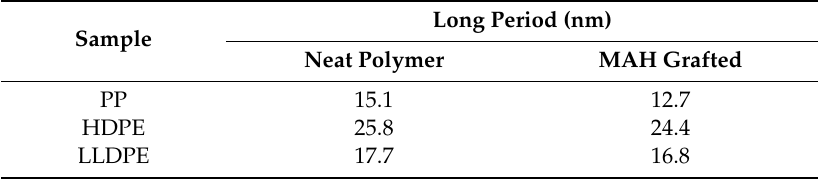
Table 3. Long period obtained from Lorentz-corrected SAXS